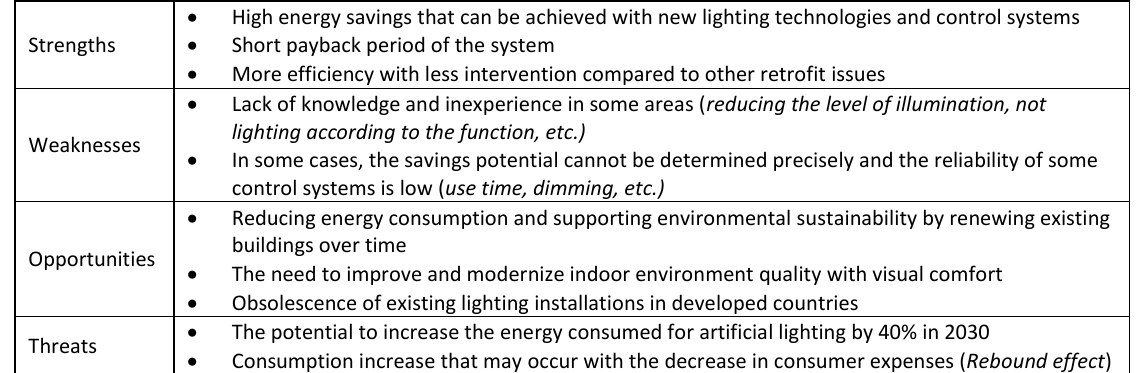
Table 1 Retrofit SWOT analysis (IEA SHC,